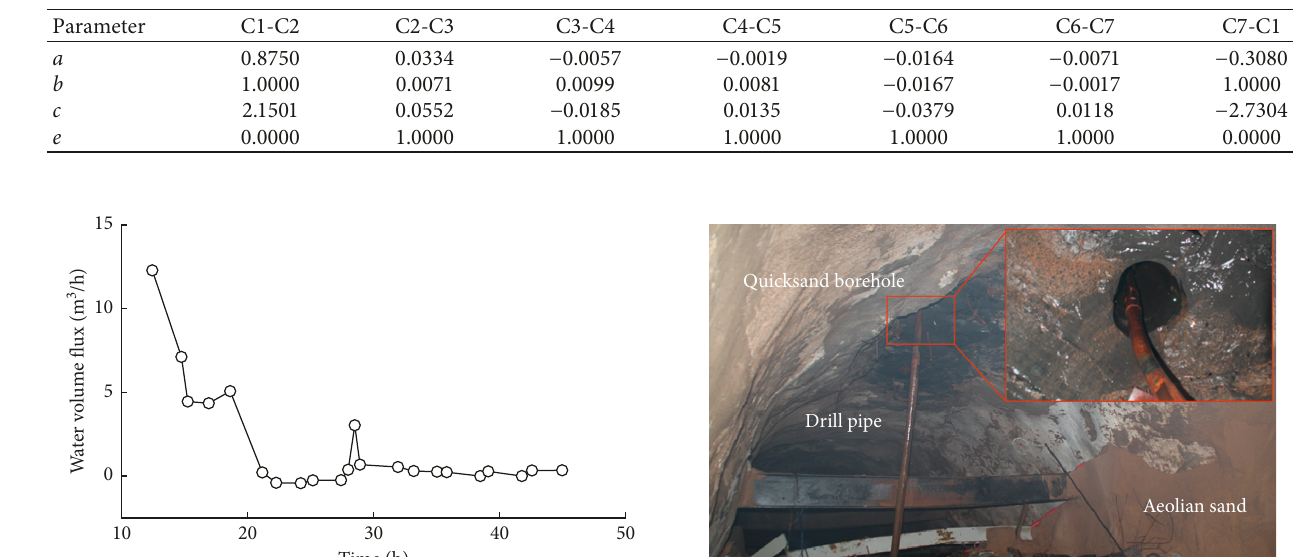
Table 2: Parameters of plane